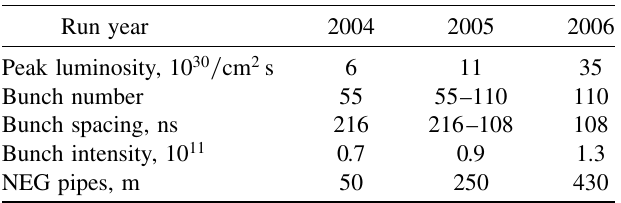
TABLE II. RHIC polarized proton runs in 2004, 2005, and 2006.